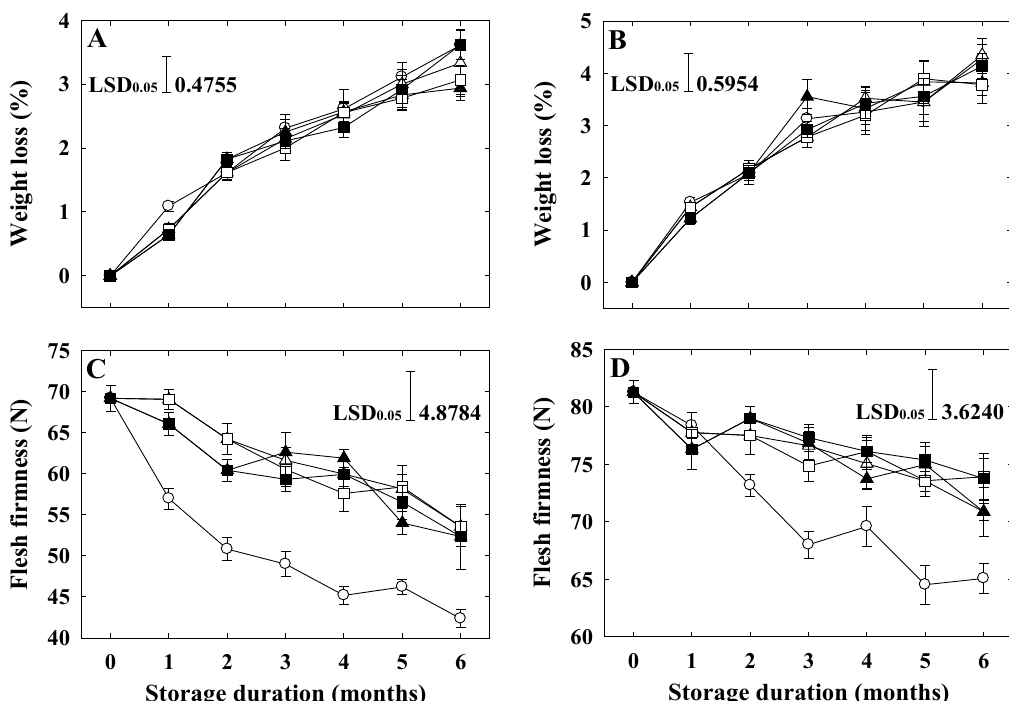
Figure 1. Fruit weight loss and flesh firmness of ‘Arisoo’ ( A , C ) and ‘Picnic’ ( B , D ) apples during cold storage at 0 ± 1 °C with 90–95% relative humidity for up to six months. Fruits were treated with 0.5 μL L −1 1-MCP ( ∆ ) and 1 μL L −1 1-MCP ( ▲ ) at harvest, and 0.5 + 0.5 μL L −1 1- MCP (□) and 1 + 1 μL L −1 1-MCP ( ■ ) at harvest and 2 months after storage, and untreated as control ( ○ ). Data are presented as mean ± standard error ( n = 15).